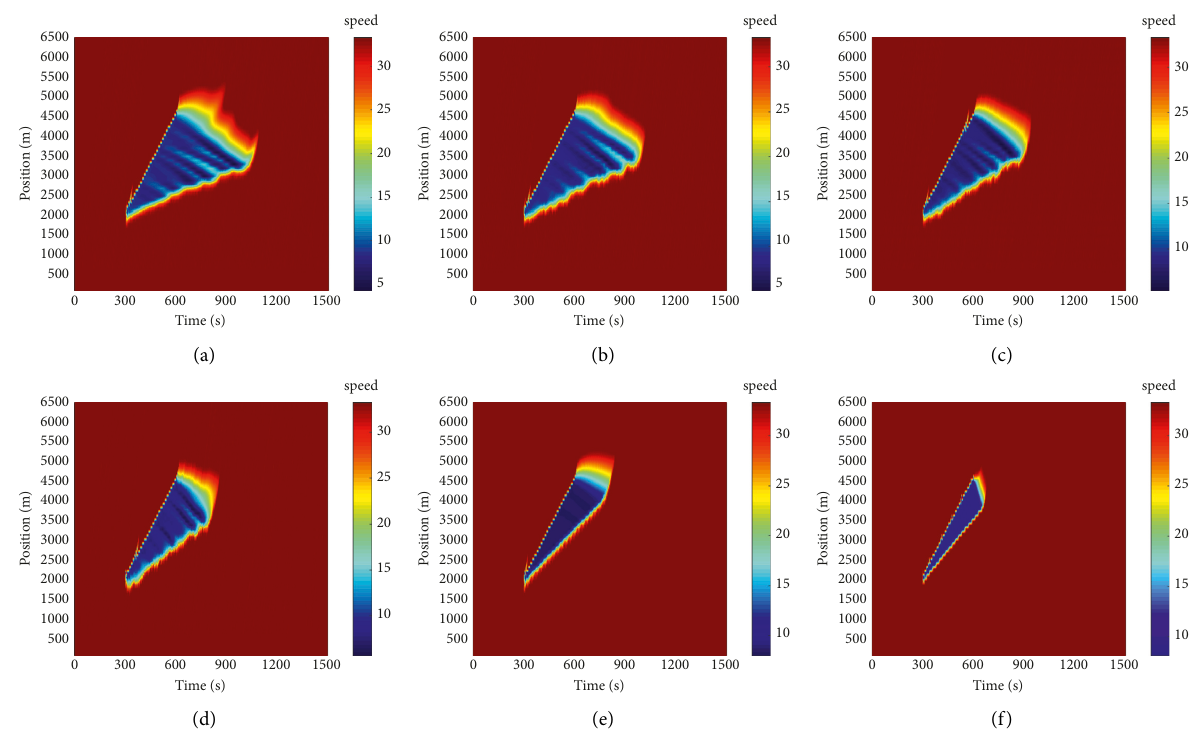
Figure 8: Speed heat map based on the car-following model: (a) p � 0, (b) p � 0 . 2, (c) p � 0 . 4, (d) p � 0 . 6, (e) p � 0 . 8, and (f) p � 1.